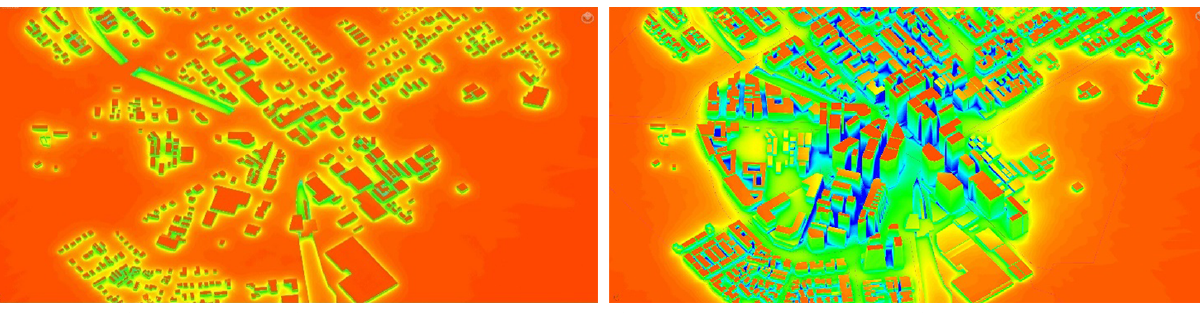
Figure 14. Left: screen grab of GPU based SVF calculation performed on the town centre of Beenleigh, in the City of Lo- gan, Queensland, Australia. Right: GPU based SVF calculation performed on currently proposed master plan height and setbacks, resulting in clearly visible increased urban canyon (low level of SVF shown in